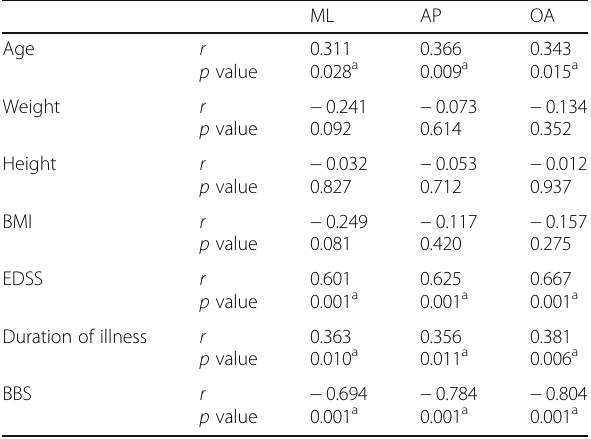
Table 6 Correlation between BSS parameters (mediolateral, anteroposterior, and overall) and the patients ’